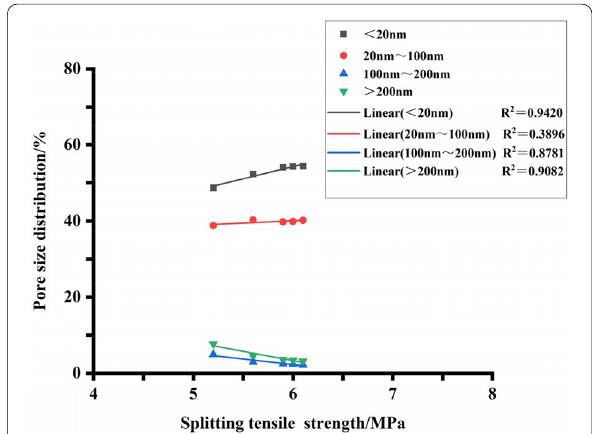
Fig. 27 Relationship between critical pore diameter and compressive strength.